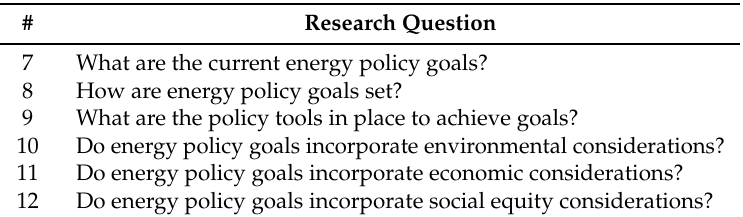
Table 3. Policy goal and priority questions.